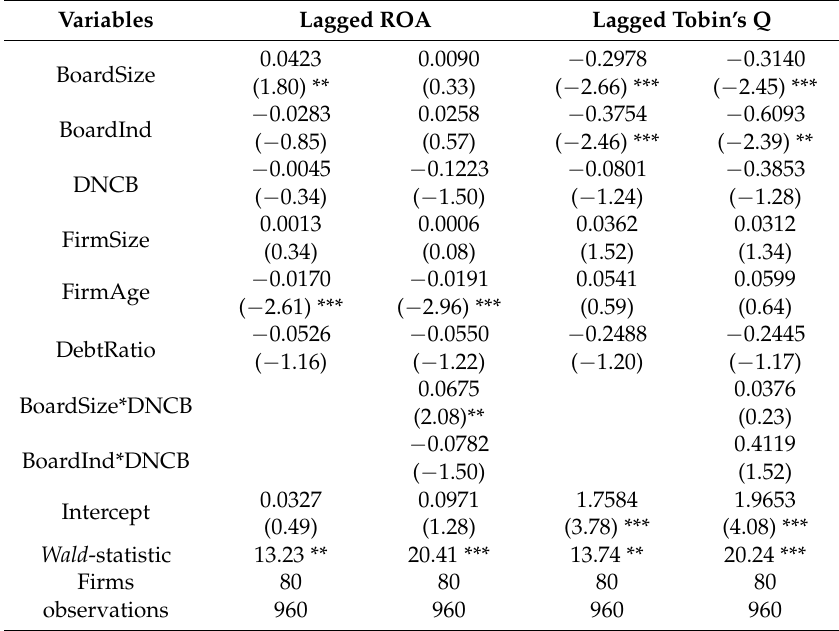
Table 4. Regressions results. This table reports the results of our regressions; z -statistics are reported in